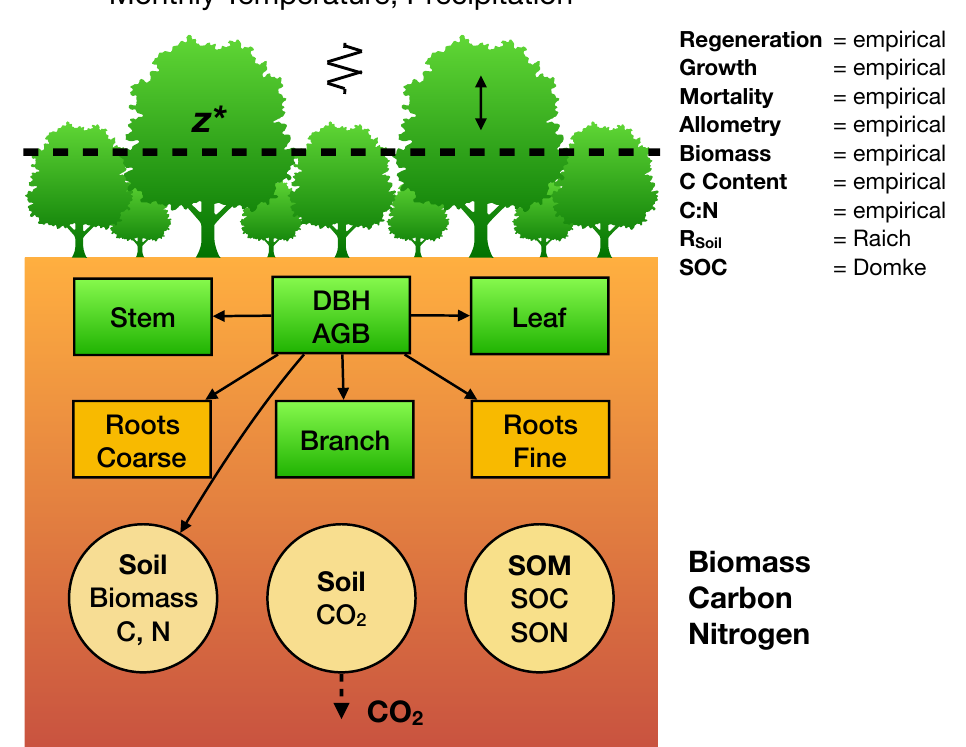
Figure 2. Perfect Plasticity Approximation with Simple Biogeochemistry (PPA-SiBGC) model structure; Raich et al. [116]; Domke et al.